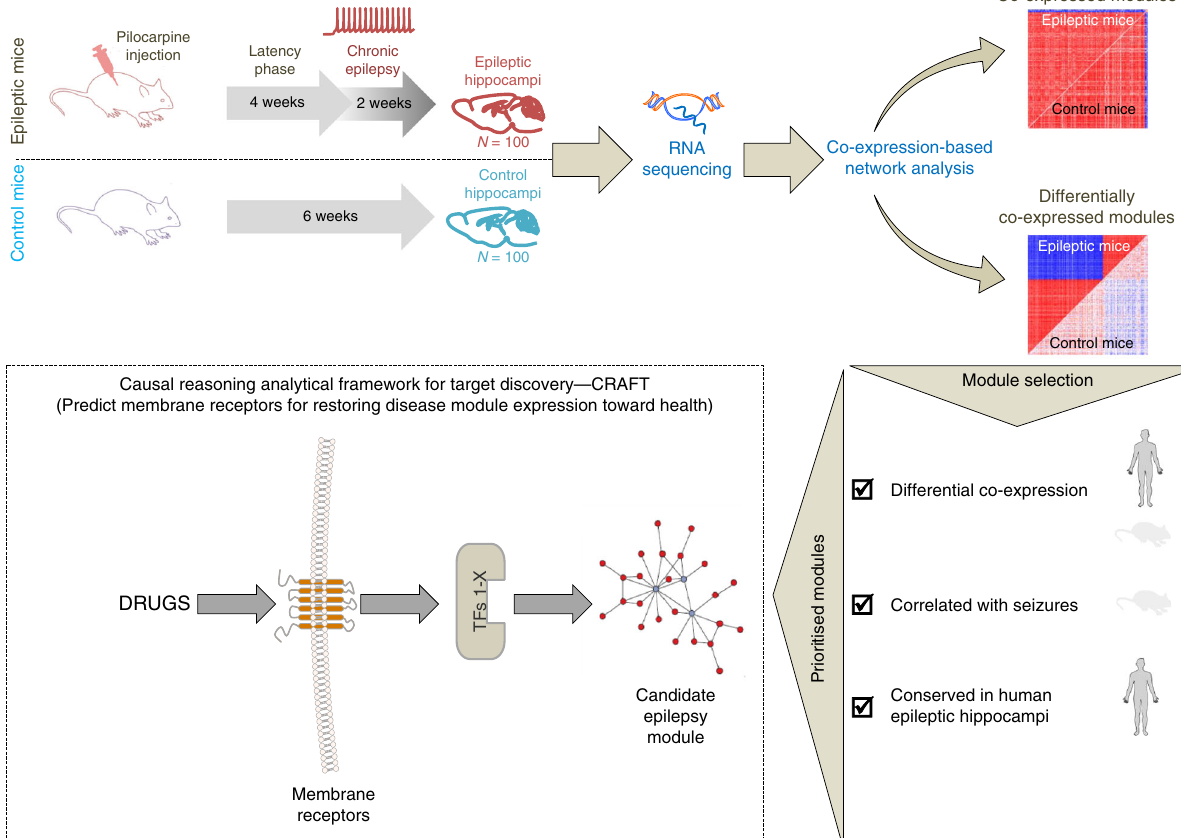
Fig. 1 Experimental plan and study overview. We studied 100 mice with epilepsy (pilocarpine post status epilepticus model of temporal lobe epilepsy) and 100 control (pilocarpine-naïve) matched littermate mice. At 4 weeks post status epilepticus, each mouse was continuously monitored using 3D accelerometry and video monitoring for 14 days to record seizure frequency and severity. High-throughput mRNA sequencing (RNA-seq) was generated using RNA from snap-frozen whole hippocampus samples from the mice and gene expression pro fi les were used to generate co-expression modules. Co- expression modules with a potential relationship to epilepsy were prioritized using the following criteria: (i) differential co-expression between epileptic and healthy hippocampus (mouse and human TLE), (ii) correlation of module expression with seizure frequency (mouse), and (iii) conservation in the human epileptic hippocampus. Modules meeting these criteria were considered candidate modules for epilepsy, and subjected to CRAFT analysis to